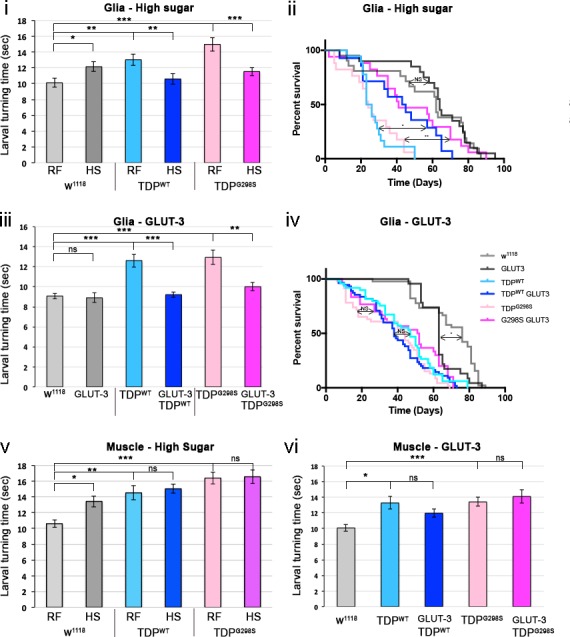
A high sugar diet or GLUT-3 overexpression are partially protective when TDP-43 is expressed in glia but not in muscles.(i, ii) Larval turning assays (i) and lifespan assays (ii) on a high sugar diet (HS) compared to a regular sugar diet (RF). Genotypes as indicated. (iii and iv) Larval turning assays (iii) and lifespan assays (iv) for GLUT-3 overexpression alone or in conjunction with TDP-43. Genotypes as indicated. (v and vi) Larval turning assays on HS versus RF (v) or in the context of GLUT-3 and TDP-43 overexpression in muscles (vi). Kruskal-Wallis test was used for larval turning assays and Log-rank or Mantel-Cox tests were used for lifespan assays to determine significance.10.7554/eLife.45114.015Figure 4—figure supplement 2—source data 1.(i) Glia HS LT; (ii) Glia HS SC; (iii) Glia Glut3 LT; (iv) GLUT3 Glia SC; (v) Muscle HS LT; (vi) Muscle Glut3 LT.